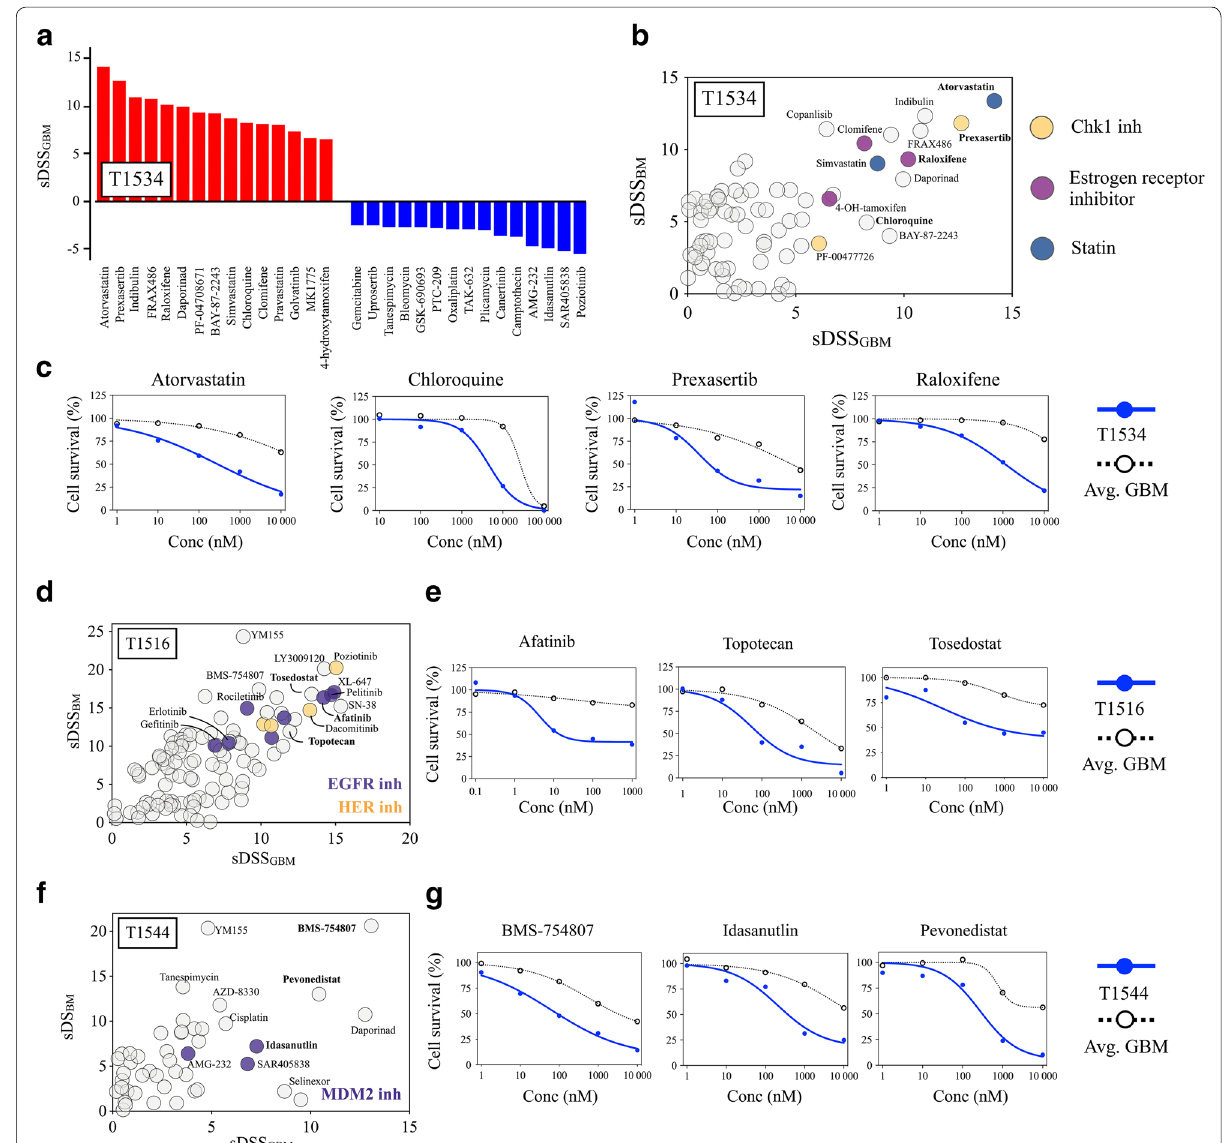
Fig. 5 Individual therapeutic options in recGSC cultures. a Waterfall plot of the 15 most (red) and 15 least selective (blue) drug responses in T1534 by sDSS GBM . The plot displays the sensitivity to e.g. statins and estrogen receptor inhibitors, and the resistance to MDM2 inhibitors (SAR405838, AMG‑232, Idasanutlin). b Dot plot of sDSS in T1534 using both the GBM (x‑axis) and healthy bone marrow (y‑axis) reference databases. Classes (color coded) and single drugs with patient‑specific activity in T1534 are highlighted. c The corresponding dose–response curves of selected drug responses in T1534. d , e Similar dot plot and selected dose–response curves in T1516. T1516 displayed a remarkable sensitivity to EGFR‑ and HER‑inhibitors, of which several with approval status available for fast translation. f , g Dot plot and selected dose‑response curves in T1544. T1544 was among the least sensitive tumors, and displayed an increased sensitivity to MDM2‑inhibitors, that currently are evaluated in clinical trials of GBM